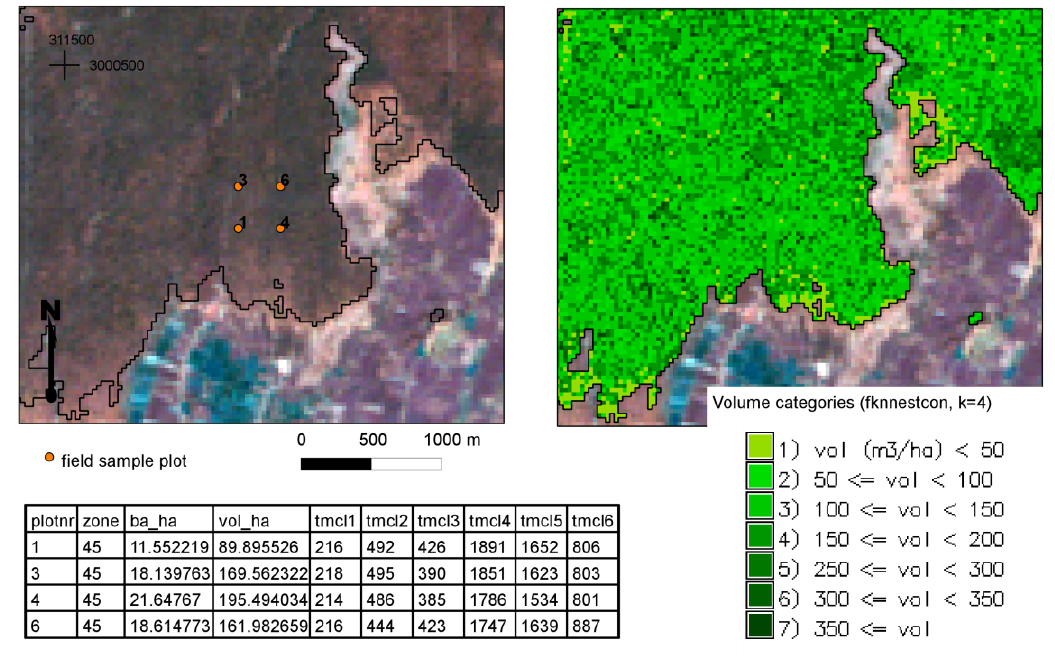
Figure 8. At left: forest cover map (vector boundaries) and a field sample plot cluster, (plotnr = sample plot number; zone = UTM zone number; ba_ha = basal area, m 2 ∙ha −1 ; vol_ha = volume, m 3 ∙ha −1 ; tmcl1–tmcl6 = pixel values in the Landsat TM mosaic bands 1–6). At right: A thematic map of the volume. An example from eastern Terai (background: a composite of Landsat TM mosaic bands 5, 3 and 2 (rgb)). (Coordinate reference system: WGS 84/UTM zone